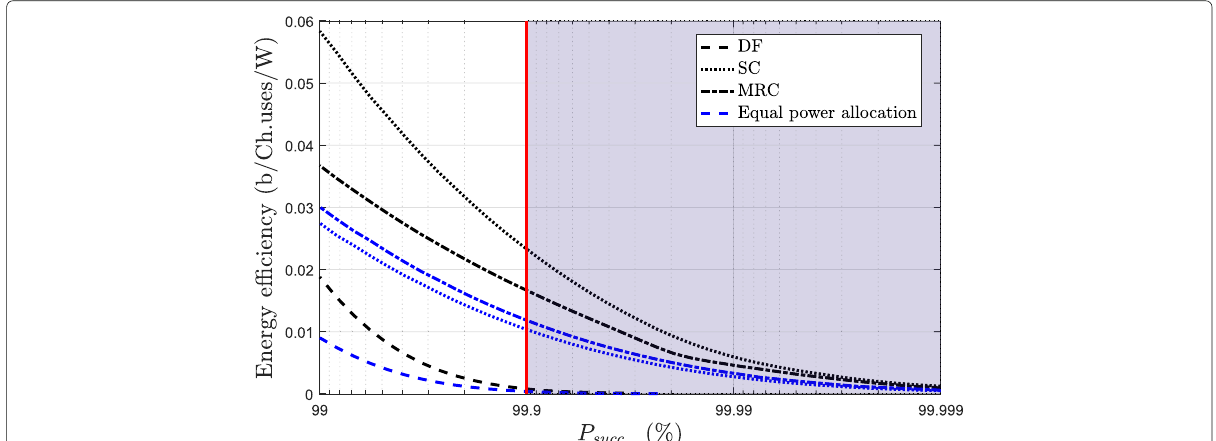
Fig. 10 Energy efficiency of DF, SC, and MRC scenarios under EPA and OPA strategies. This figure compares the energy efficiency in DF, SC and MRC cooperative schemes under EPA and OPA strategies as function of reliability. We show that under EPA, MRC is the most energy-efficient strategy